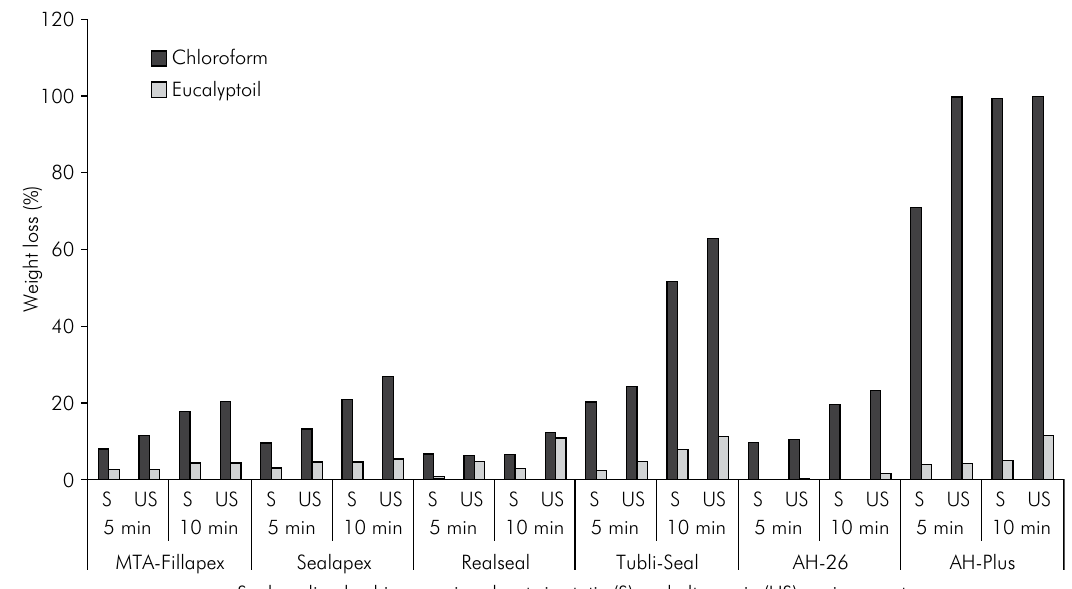
Figure. Dissolution of sealers in chloroform and eucalyptoil in static and ultrasonic environments for 5- and 10-min immersion periods.